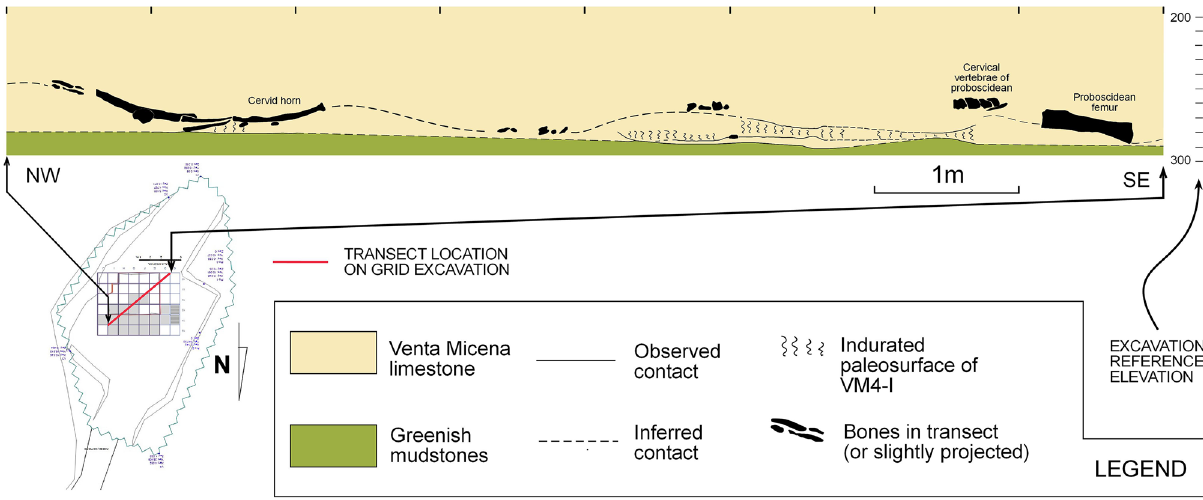
Figure 7. Topographic section of